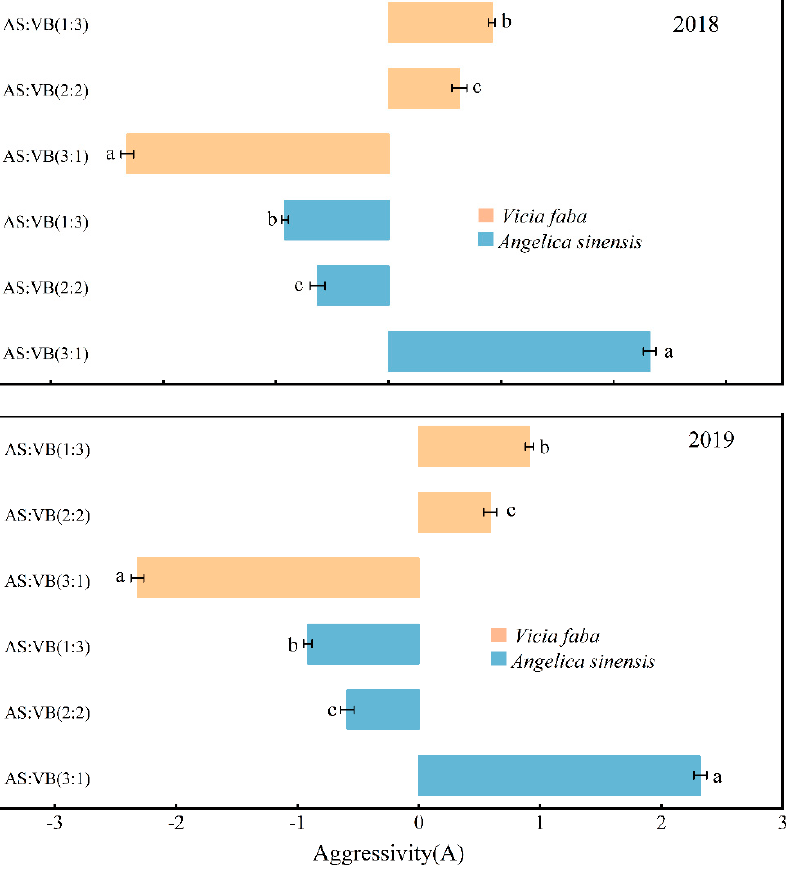
Figure 3. Aggressivity between A. sinensis and V. faba over 2018 and 2019 under the intercropping systems. Within a year, per companion crop, bars bearing the different letter are significantly diferent at p < 0.05. Error bars represent the standard deviation of the means. AS/VF (3:1), three rows of A. sinensis + one row V. faba ; AS/VF (2:2), two rows of A. sinensis + two rows V. faba ; AS/VF (1:3), one row of A. sinensis + three rows of V. faba